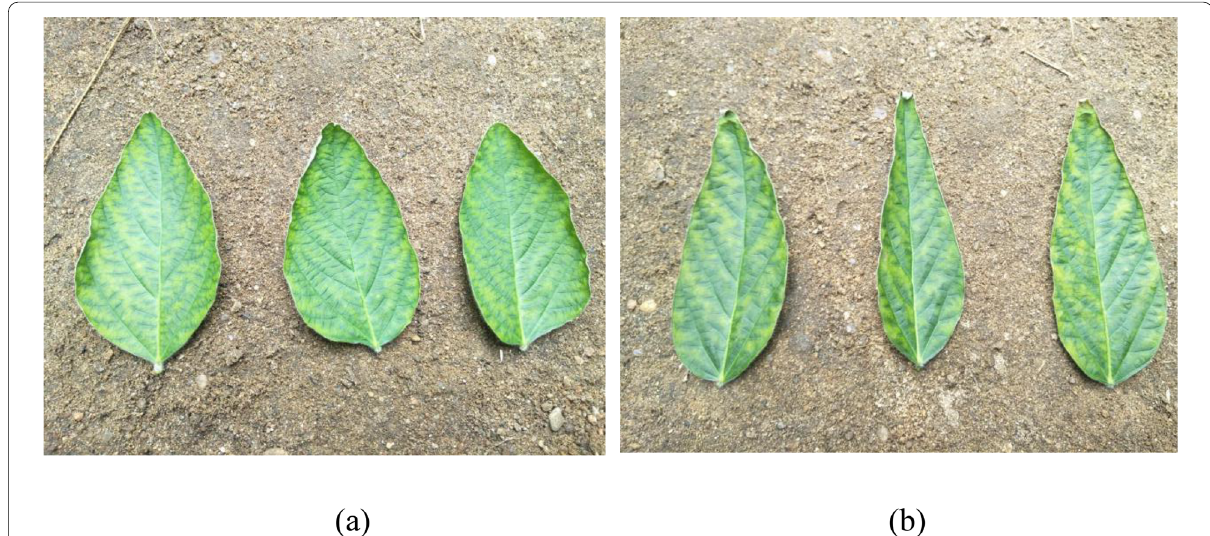
Fig. 1 Leaf status of two soybean varieties under drought stress. a drought-resistant HN44; b drought-sensitive HN65